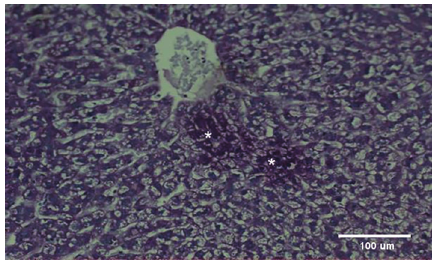
Figure 1. Spot necrosis (marked with asterisks) and vacuolar degeneration in liver tissue of control group rabbits (periodic acid- Schiff